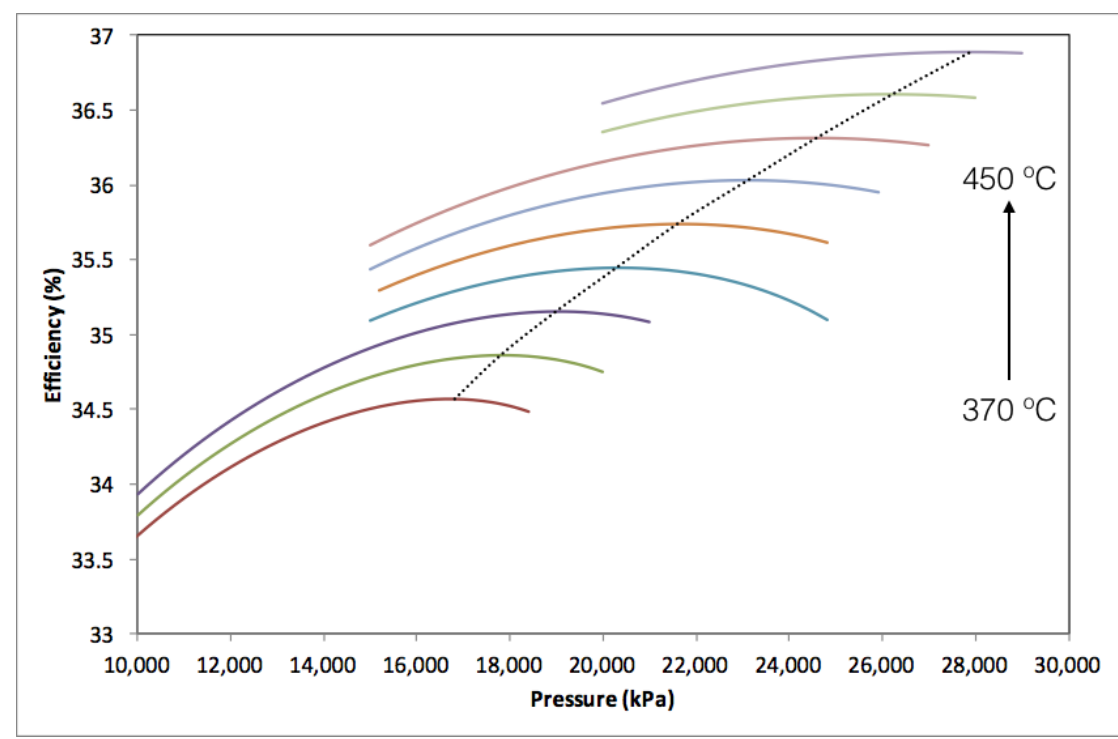
Figure 4. Efficiency versus pressure for the Rankine cycle at temperatures from (370–450 °C), with Figure 4. E ffi ciency versus pressure for the Rankine cycle at temperatures from (370–450 ◦ C), adiabatic efficiency of 89.9%. The turbine exit pressure is 10 kPa. Dotted line represents the optimum with adiabatic e ffi ciency of 89.9%. The turbine exit pressure is 10 kPa. Dotted line represents pressure. the optimum